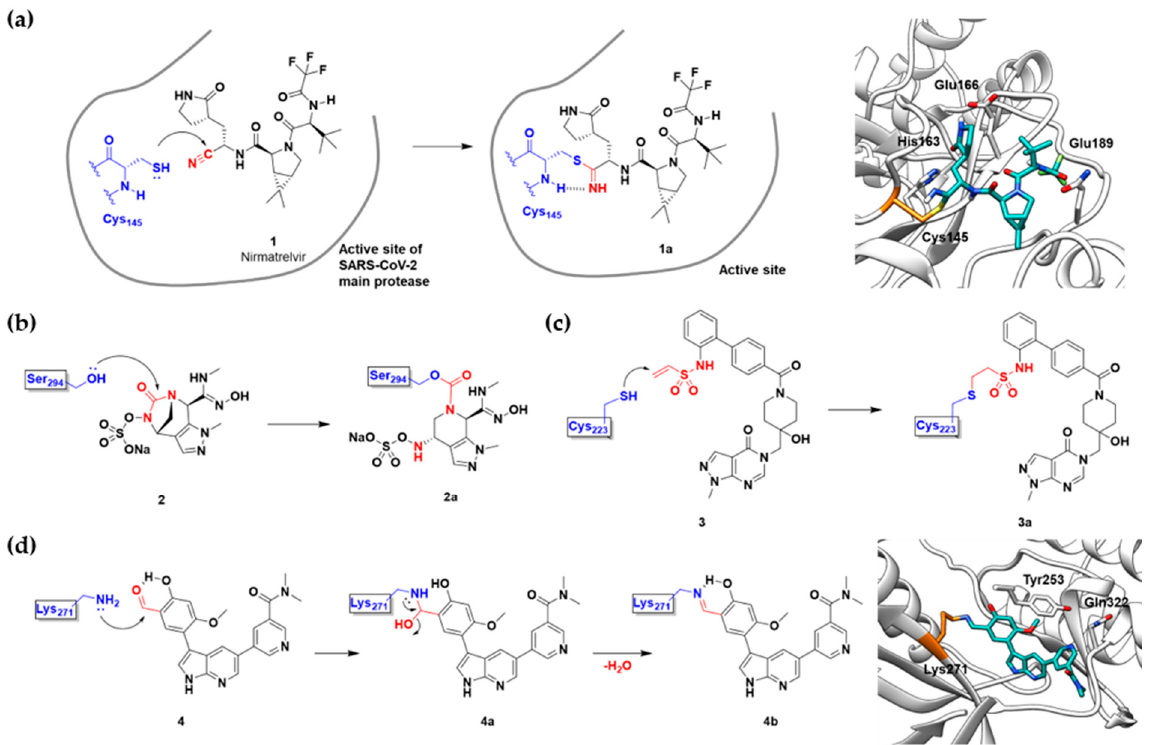
Figure 3. Representative examples of conventional covalent inhibitors: ( a ) schematic diagram and co- crystal structure of SARS-CoV-2 main protease with covalent inhibitor 1 (nirmatrelvir) (PDB: 7RFW). Nirmatrelvir is bound to the catalytic cysteine residue of the protease active site. Mechanism of the reaction between cysteine and nitrile warhead of nirmatrelvir generating thioimidate adduct 1a is shown. Hydrogen bonding between cysteine α -amine and thioimidate stabilizes the covalent complex; ( b ) mechanism of the reaction between serine and diazabicyclooctane warhead of the covalent inhibitor 2 generating carbamate adduct 2a ; ( c ) mechanism of the reaction between cysteine and vinyl sulfonamide warhead of the covalent inhibitor 3 generating thioethane sulfonamide adduct 3a ; ( d ) schematic diagram and co-crystal structure of BCR-ABL kinase with covalent inhibitor 4 (PDB: 7W7Y). Mechanism of the reaction between lysine and salicylaldehyde warhead of 4 generating imine adduct 4a . Hydrogen bonding between imine and phenol stabilizes the covalent